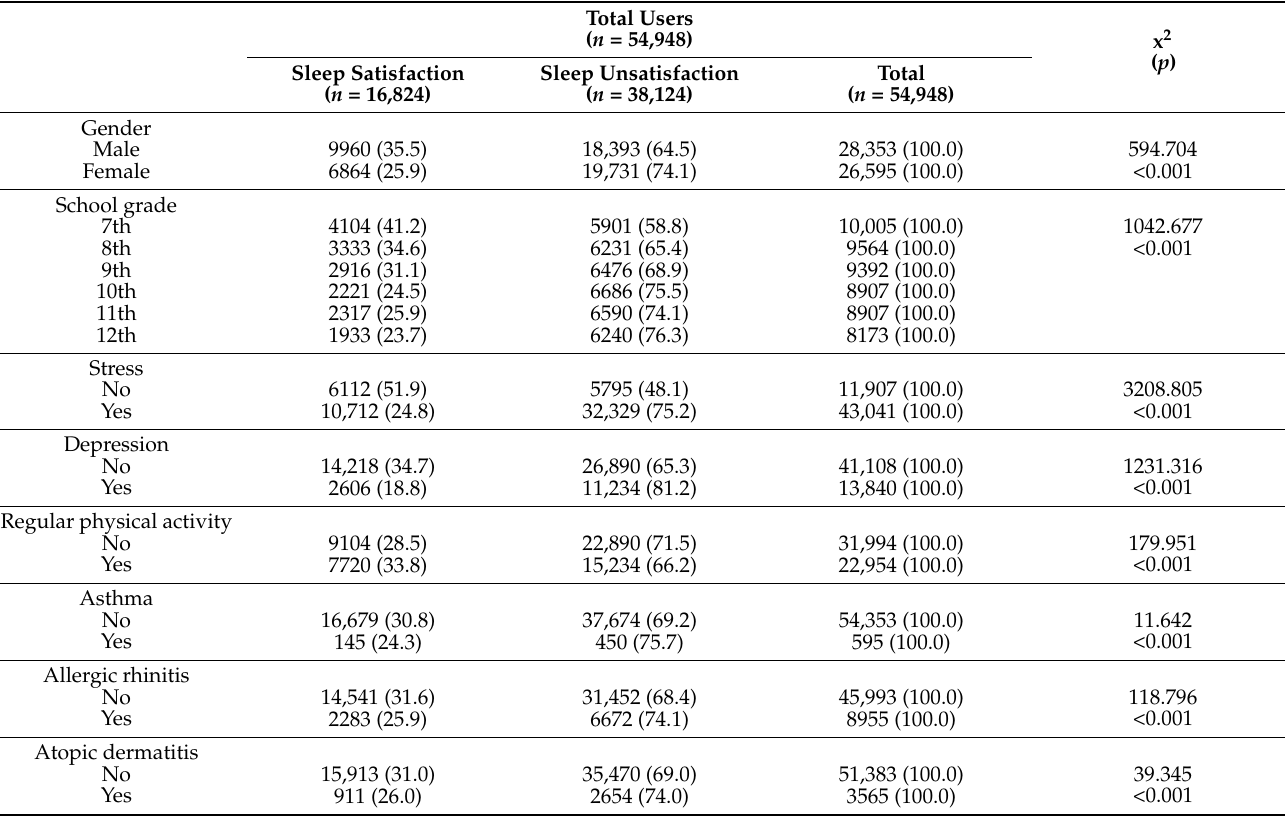
Table 2. General characteristics of participants according to sleep satisfaction.